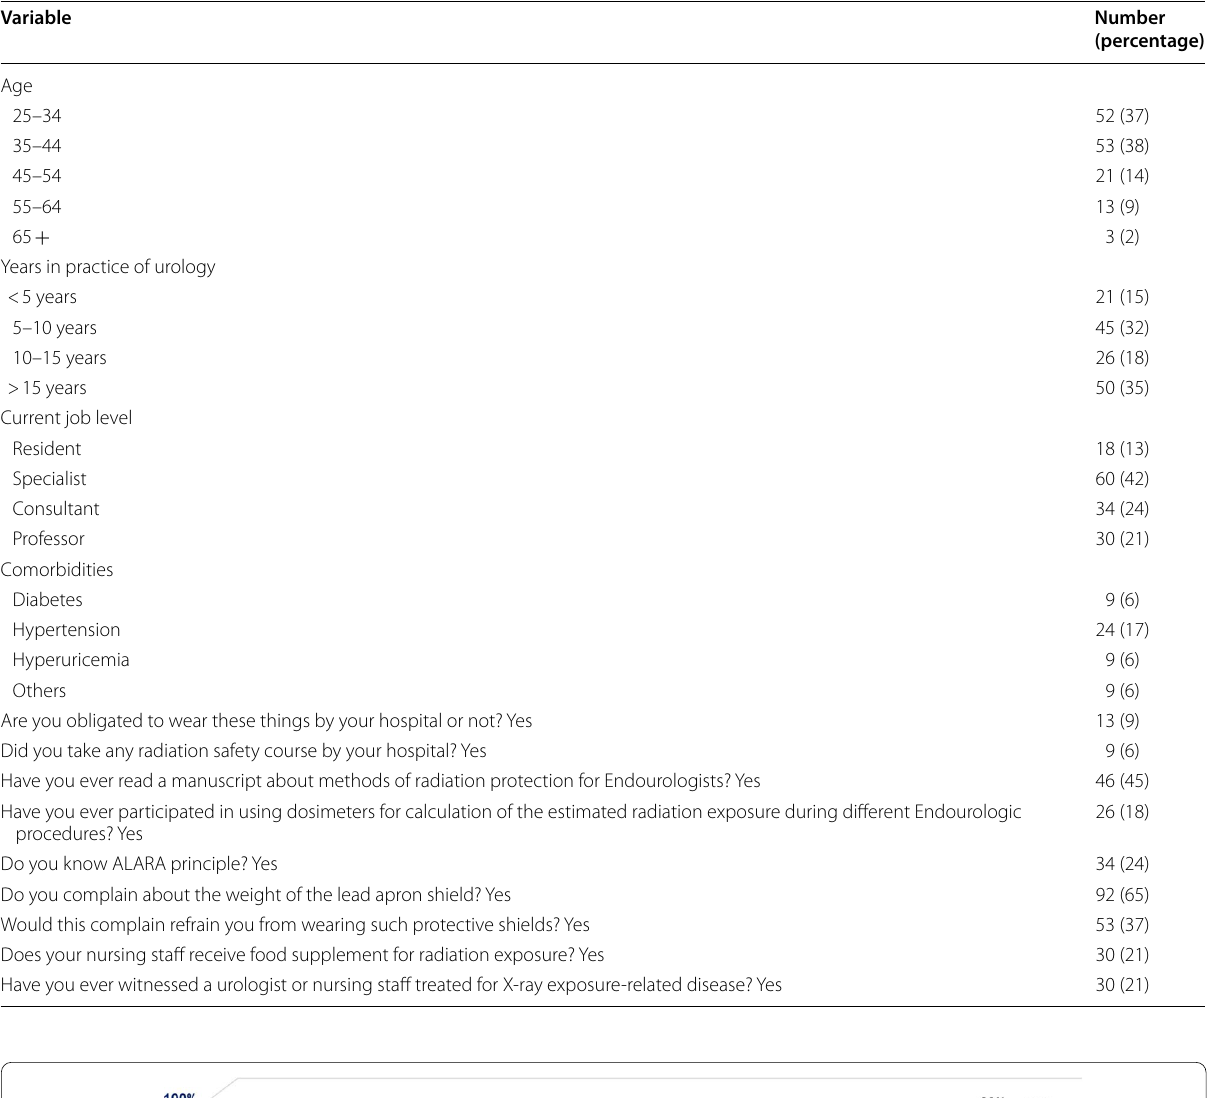
Table 1 Baseline demographics of participants and demographics of radiation safety procedures and awareness